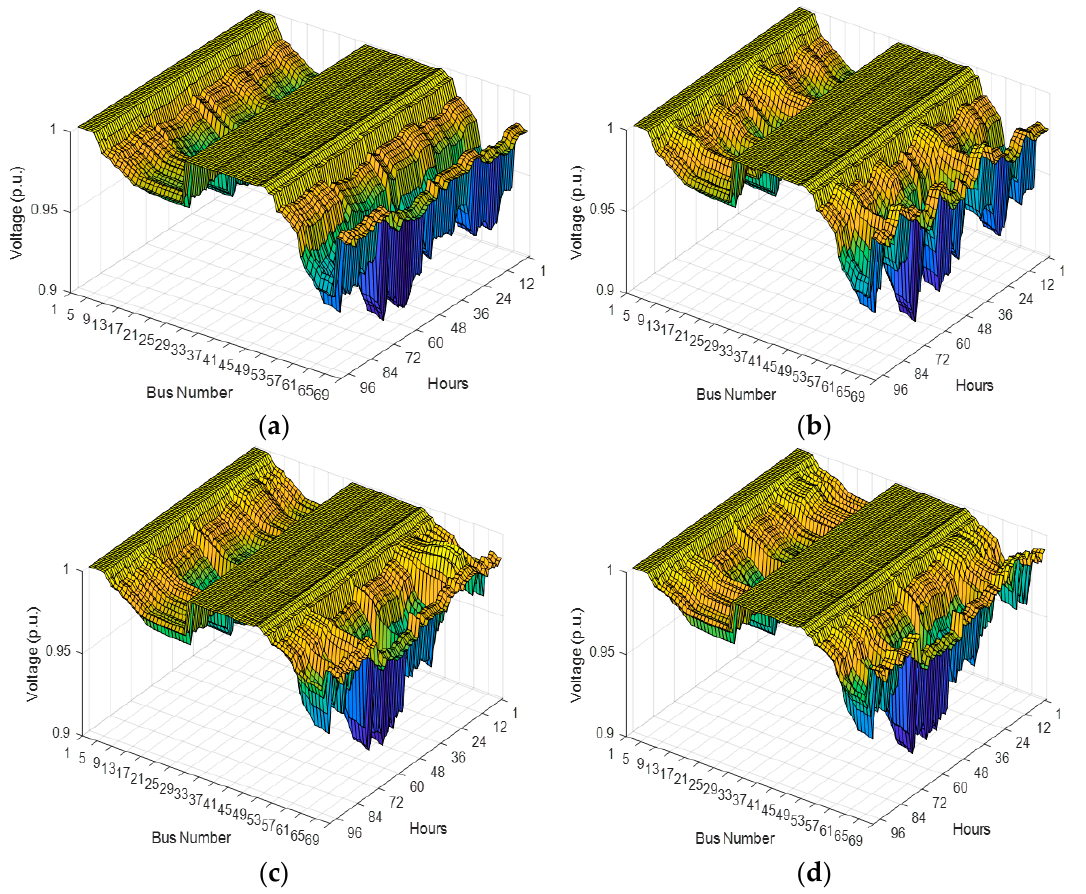
Figure 15. Seasonal voltage profiles variation for the IEEE 69-bus: ( a ) Basic case; ( b ) PVDG case; ( c ) WTDG case; ( d ) Hybrid PVDG-WTDG case.